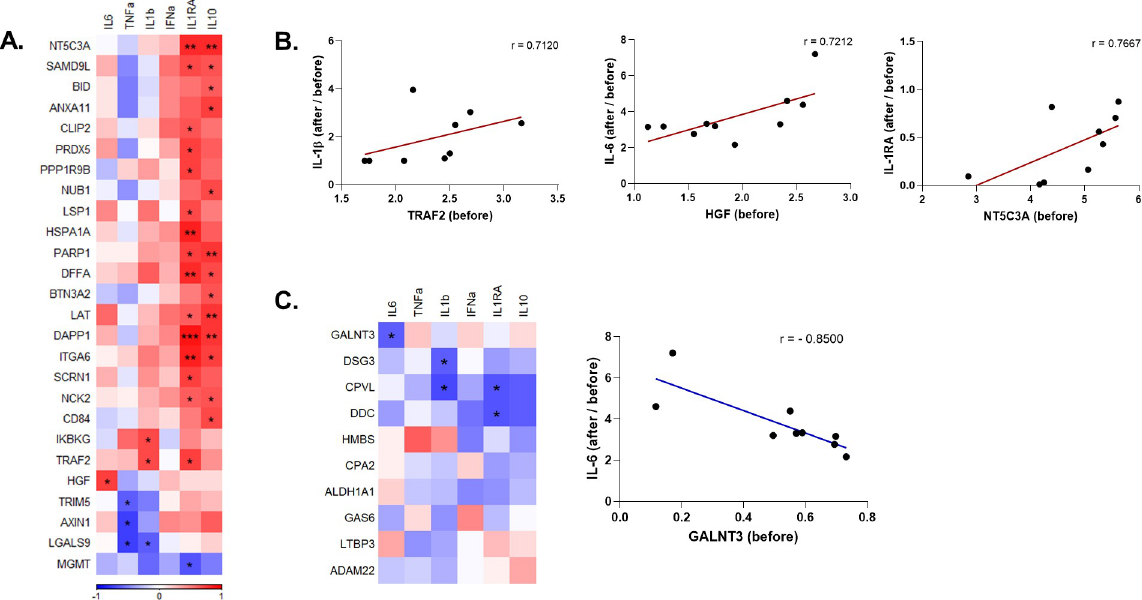
Fig 5. Correlation of ex vivo anti-SARS-CoV-2 responses with circulating inflammatory mediators that are significantly altered by influenza vaccination. A. Heatmap depicting the baseline (before vaccination) levels of inflammatory mediators that were downregulated by influenza vaccination and are significantly correlated with the induction of cytokines upon SARS-CoV-2 stimulation before vs. after vaccination. Red indicates positive correlation, and blue indicates negative correlation. B. Selected circulating protein and cytokine pairs that are significantly correlated. C. Correlation of circulating proteins that were upregulated by influenza vaccination with anti-SARS-CoV-2 cytokine responses, and dot plot depicting the association of baseline GALNT3 levels and induction IL-6 against SARS-CoV-2 after vaccination. r: Spearman’s correlation coefficient. � p < 0.05, �� p < 0.01, ��� p < 0,001.